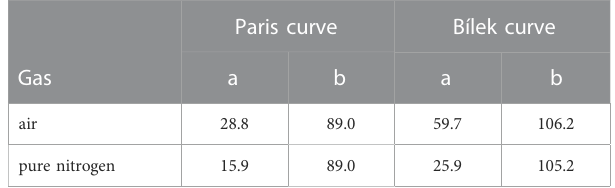
TABLE 3 Calibration curves of Paris (multiplied by factor 0.5) and Bílek, both at a pressure of 33 mbar, described by function R ( E / N ) (cid:2) aexp (− b ( E / N ) − 0 . 5 ) as plotted in the Figure